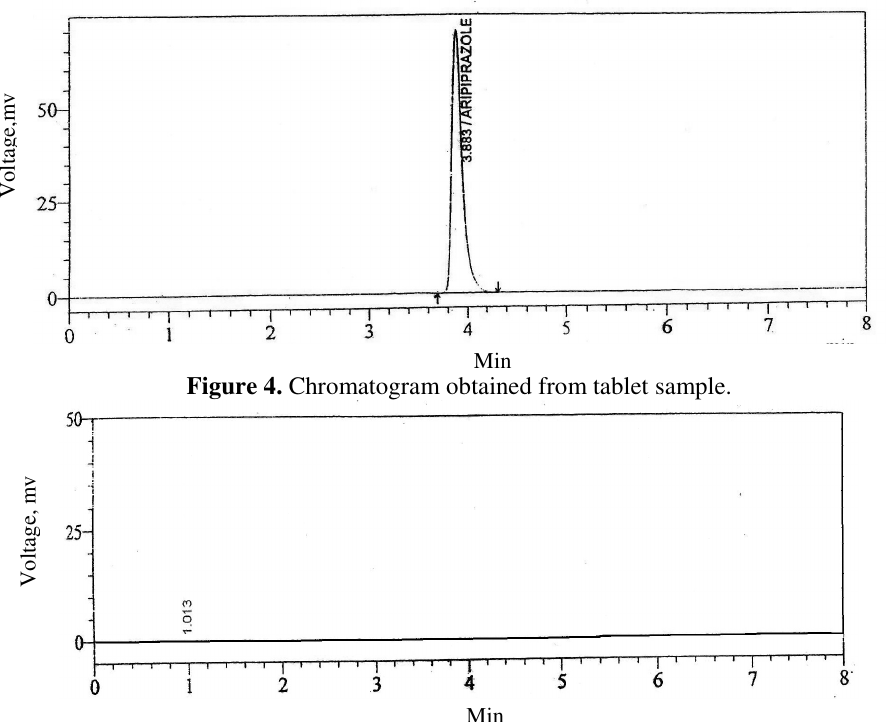
Figure 5. Chromatogram obtained from